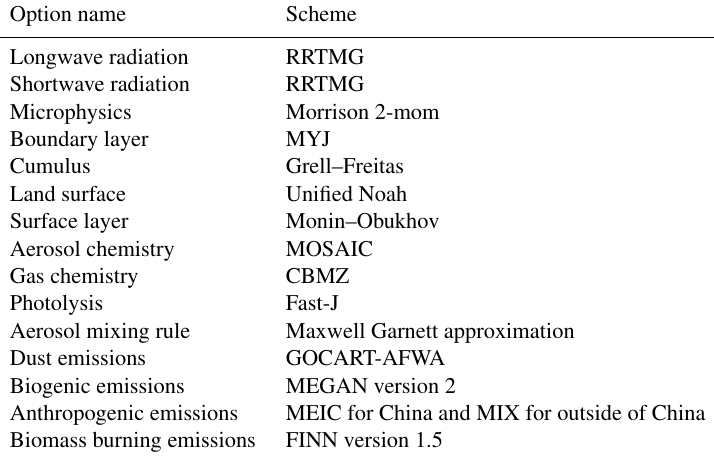
Table 1. WRF-Chem model parameterization option settings and emissions used in this study.